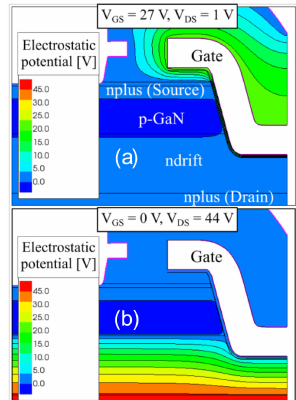
Figure 11. Simulations of breakdown conditions for the bilayer devices: ( a ) in the ON-state with V GS = 27 V and V DS = 1 V and ( b ) in the OFF-state with V GS = 0 V and V DS = 44